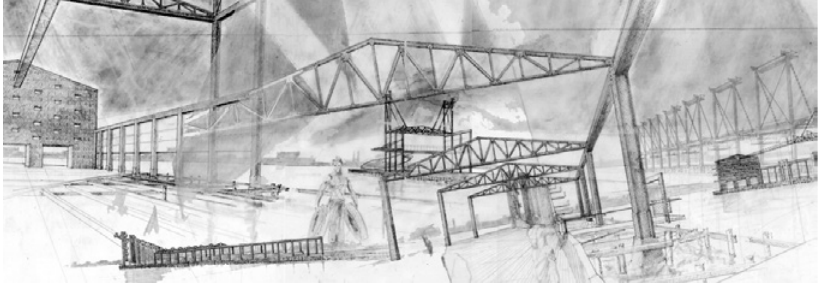
Figure 1. Safe Sex Piers . Brian